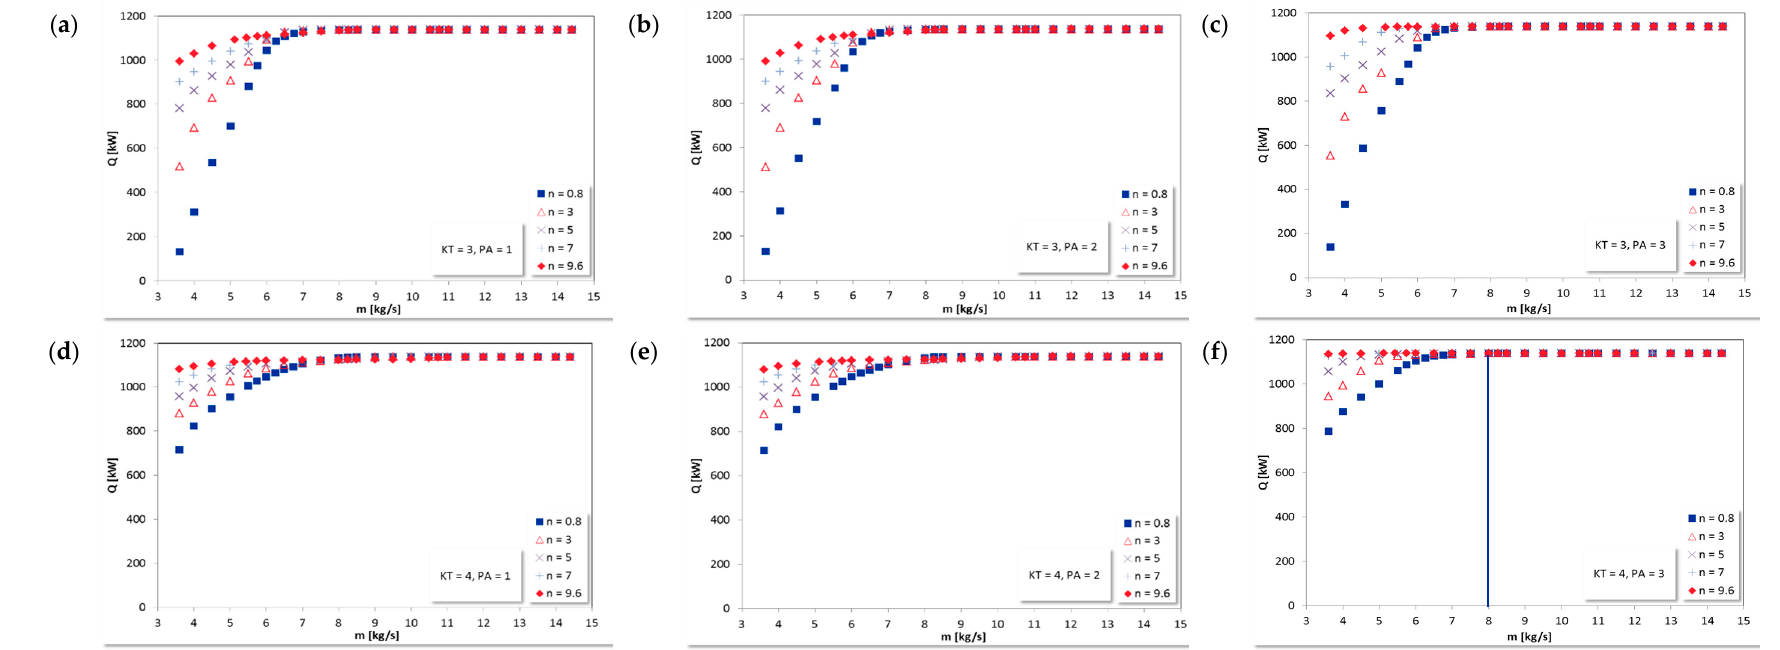
Figure 10. Influence of mass flow rates m and the number n of flooded tube rows on the total heat transfer rate of the evaporator, for enhanced tubes Turbo BII (KT = 3—The top row) and Turbo EHP (KT = 4—The bottom row). ( a ) KT = 3, PA = 1, ( b ) KT = 3, PA = 2, ( c ) KT = 3, PA = 3, ( d ) KT = 4, PA = 1, ( e ) KT = 4, PA = 2, ( f ) KT = 4, PA = 3.